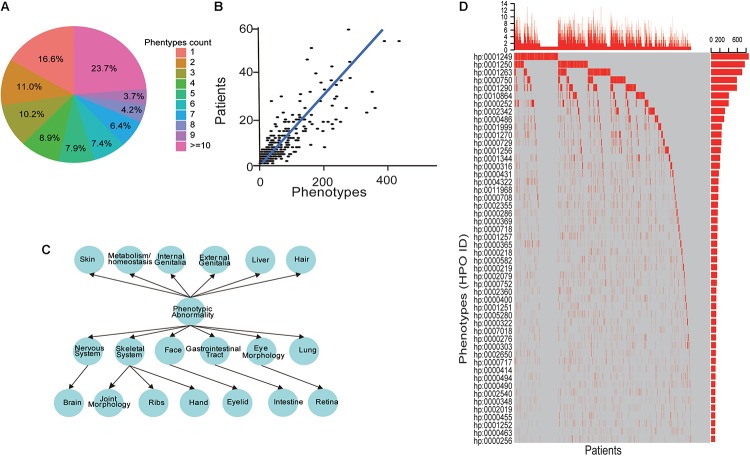
The heterogeneities of ID phenotypes. (A) The distribution of the phenotypes number for each patient. (B) A scatter point and line fitting showing the correlation between the patient number and phenotypes count. The patient number and phenotype count were derived from each gene in the database. (C) The phenotypes structure of ID patients. (D) The oncoprint-like representation of phenotypes in ID patients.